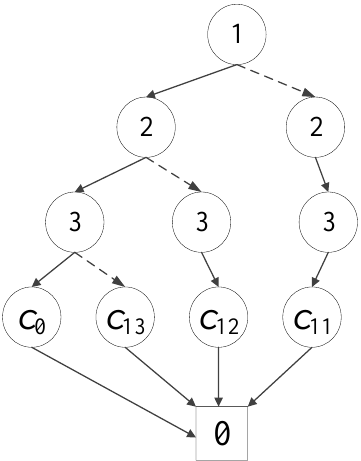
Figure 3. BDD of the example 2-out-of-3 cloud-RAID 5 with